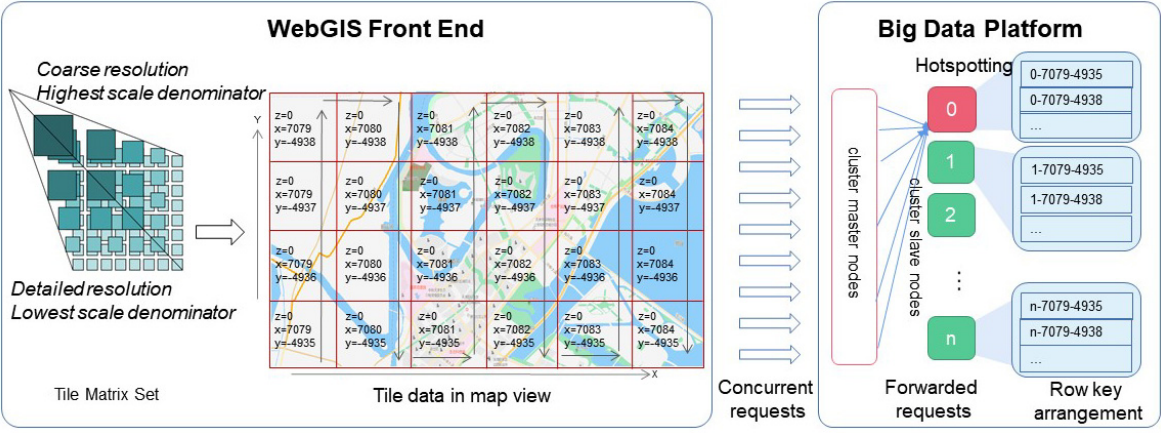
Figure 1. Formation of cluster hotspotting